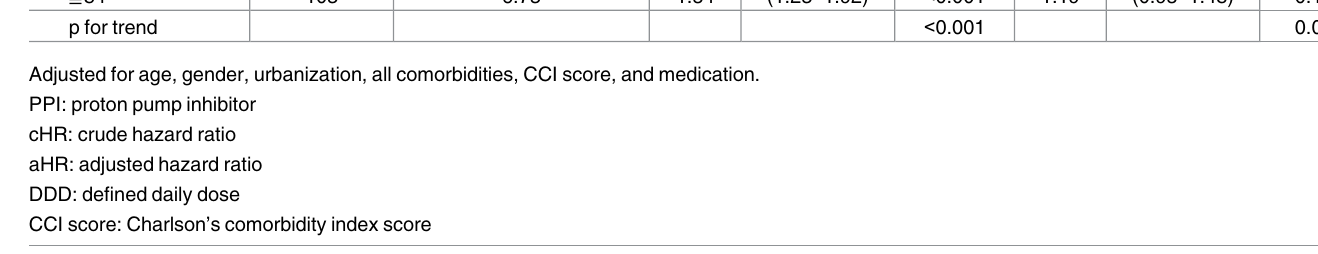
Male PPI users had significantly higher risk of developing dementia (HR, 1.24 [95%CI, non—PPI user counterparts. (Table C in S1 File) Compared with non—PPI users, PPI users without diabetes mellitus (HR, 1.29 [95%CI,